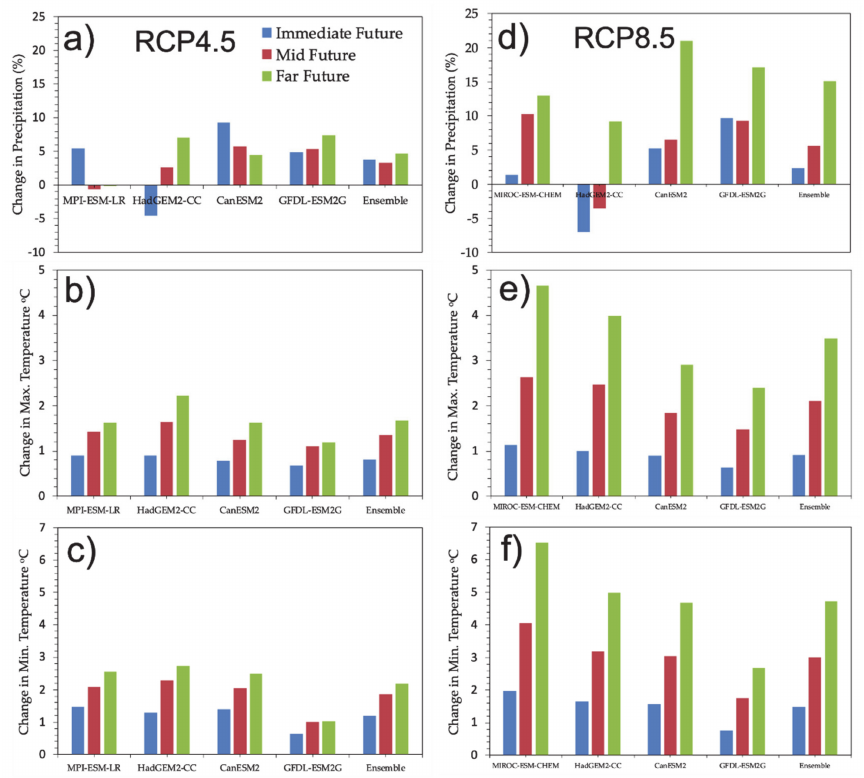
Figure 5. Change in precipitation ( a , d ) and change in temperature [maximum ( b , e ), minimum ( c , f )] pattern of the four selected GCMs and ensemble of RCPs 4.5 (left) and 8.5 (right) with their respective time windows: blue (IF), red (MF), and green